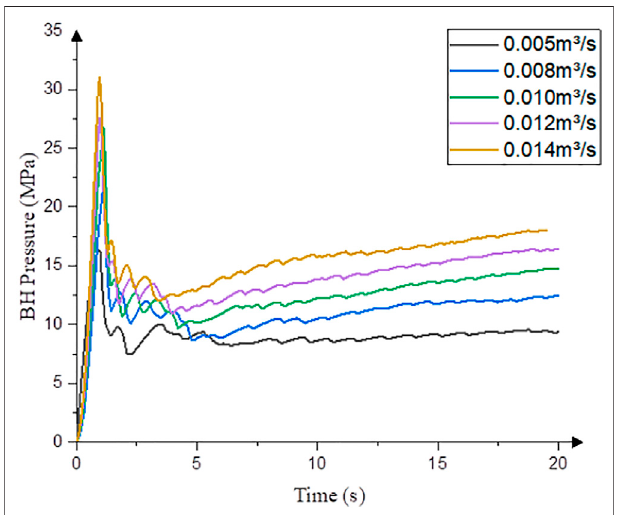
FIGURE 11 | Bottomhole pressure-time history curve.